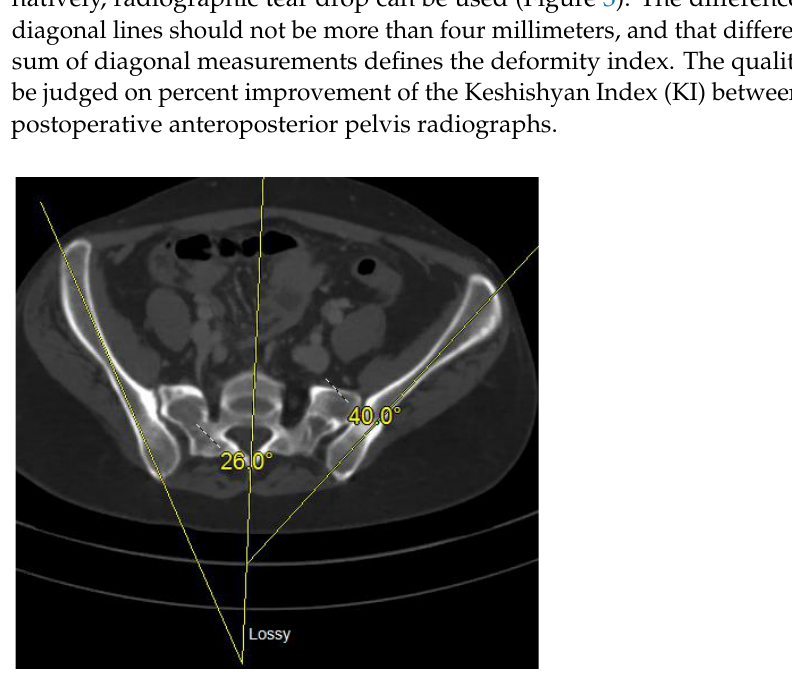
Figure 2. Axial CT image of a pelvic malunion with internal rotation deformity of the right hemi- pelvis.